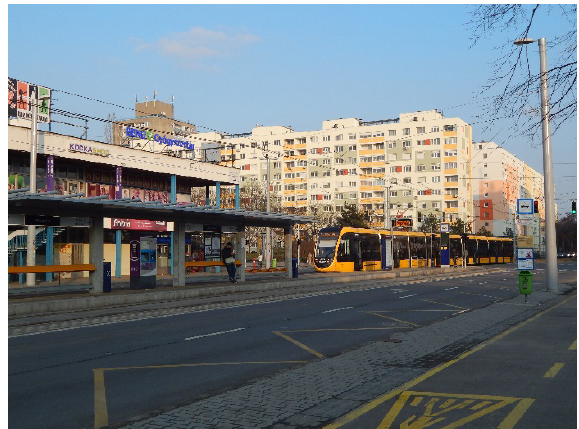
Figure 7. Kelenföld former 2-story high public center, at the crossroad of Etele and Tétényi streets, 2022 (source: